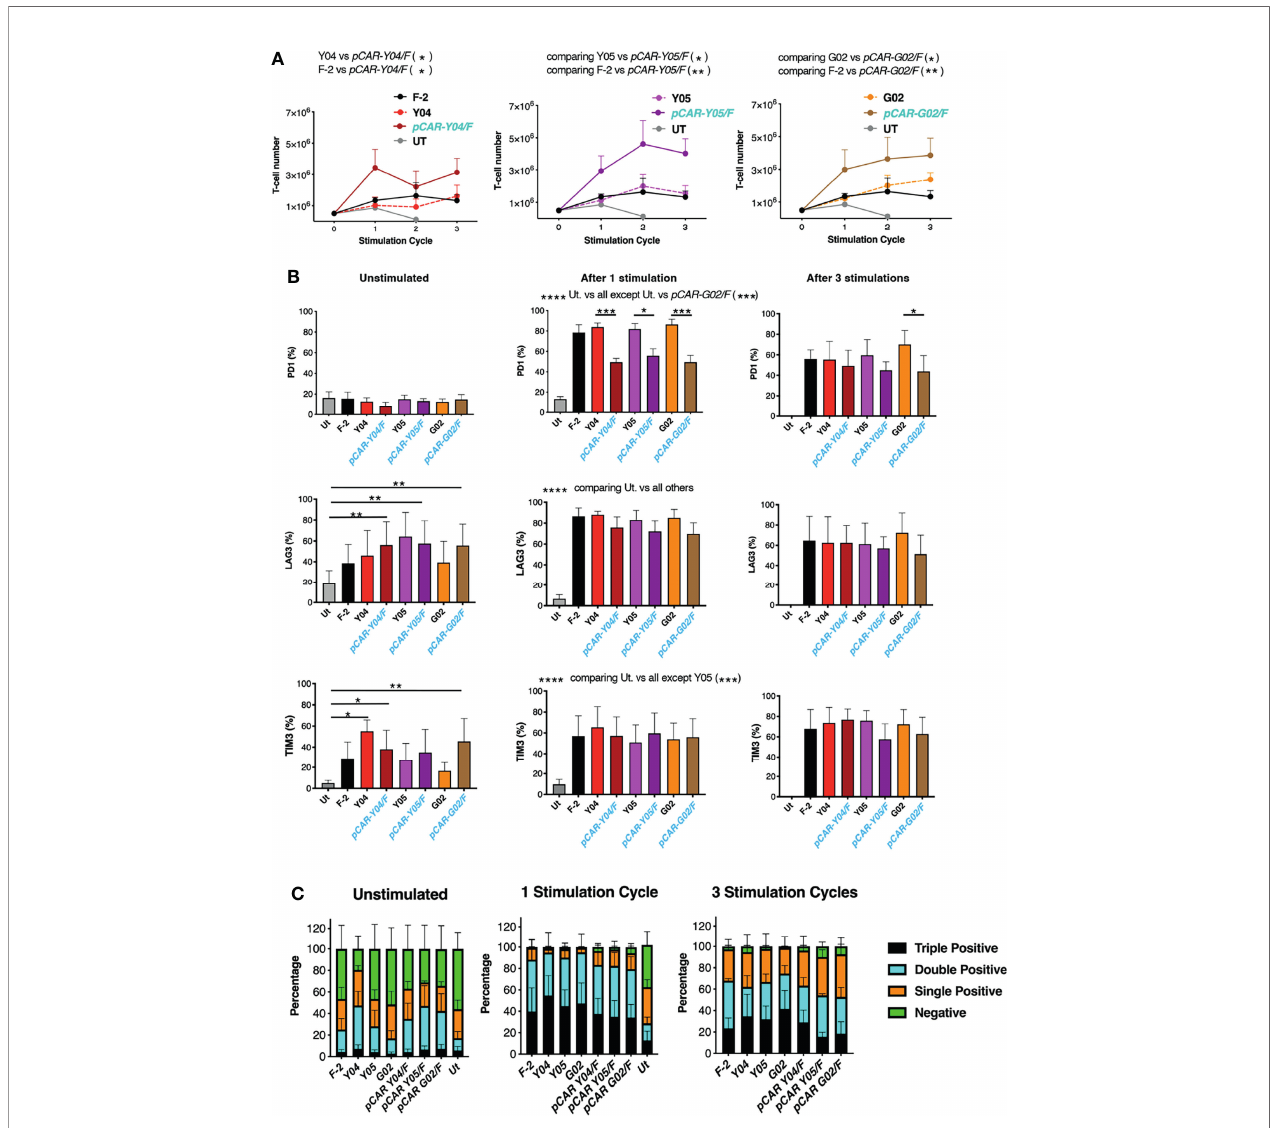
FIGURE 6 | Expansion of tumor re-stimulated pCAR T-cells is accompanied by reduced exhaustion marker expression. (A) T-cells were engineered to express the indicated CARs or pCARs. 5x10 5 of the indicated transduced CAR or pCAR T-cells were co-cultivated with 2.5x10 5 LO68-CD19 tumor cells. After 72h, T-cells were harvested, counted and transferred to a new tumor monolayer. Data show T-cell number at the time of each stimulation cycle (mean ± SEM, n=3-4). Statistical analysis was performed using an unpaired Student t -test, comparing cell number between the indicated groups over stimulation cycles 1-3. * p < 0.05; ** p < 0.01. (B) T-cells described in A that were unstimulated or 72 hours after the indicated number of stimulation (stim.) cycles were analyzed by fl ow cytometry for expression of PD1, LAG3 and TIM3. Statistical analysis was performed using two-way ANOVA with Tukey ’ s multiple comparisons. * p < 0.05; ** p < 0.01; *** p < 0.001; **** p < 0.0001. (C) Bar graph of exhaustion marker data shown in (B) Segments indicate cells that were negative or were triple, double or single positive for the exhaustion markers PD1, LAG3 and/or TIM3 (mean ±